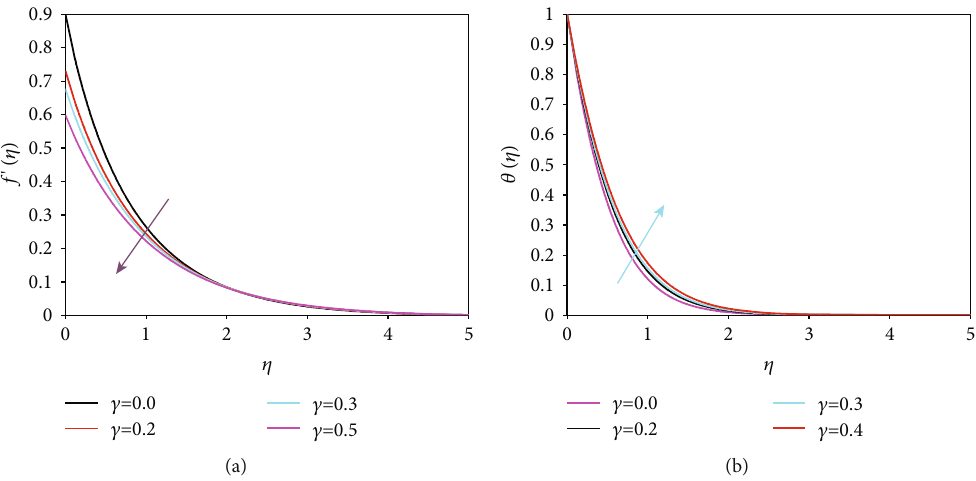
Figure 4: The graph of velocity and temperature for di ff erent values of slip parameter γ